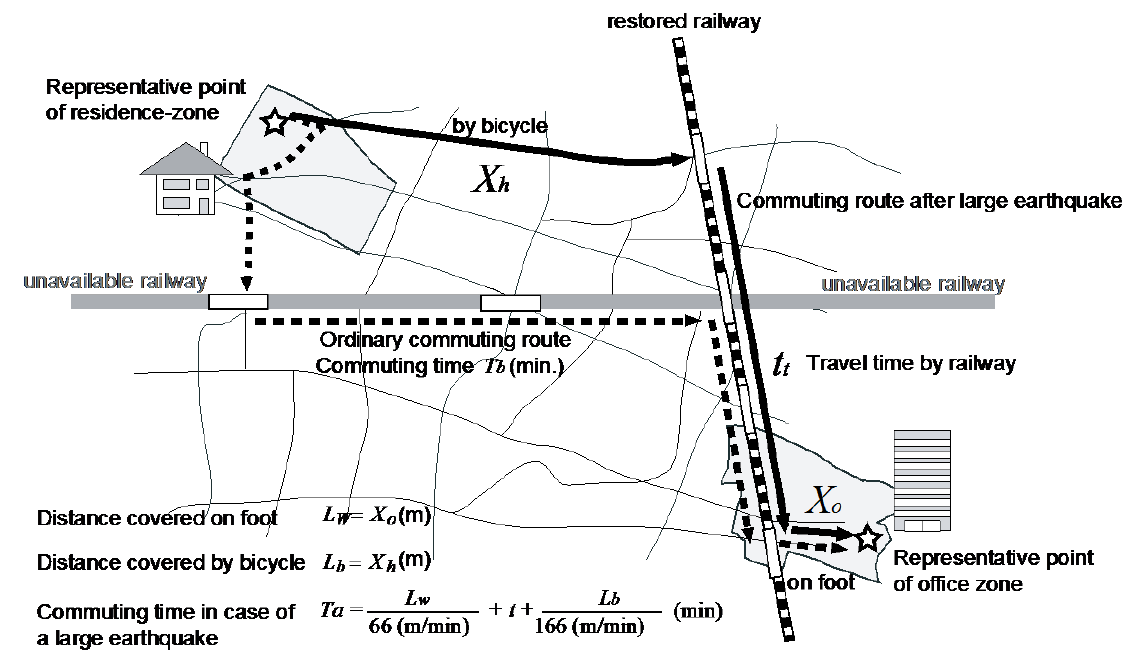
Figure 9. Method for estimating commuting routes on foot and by bicycle.